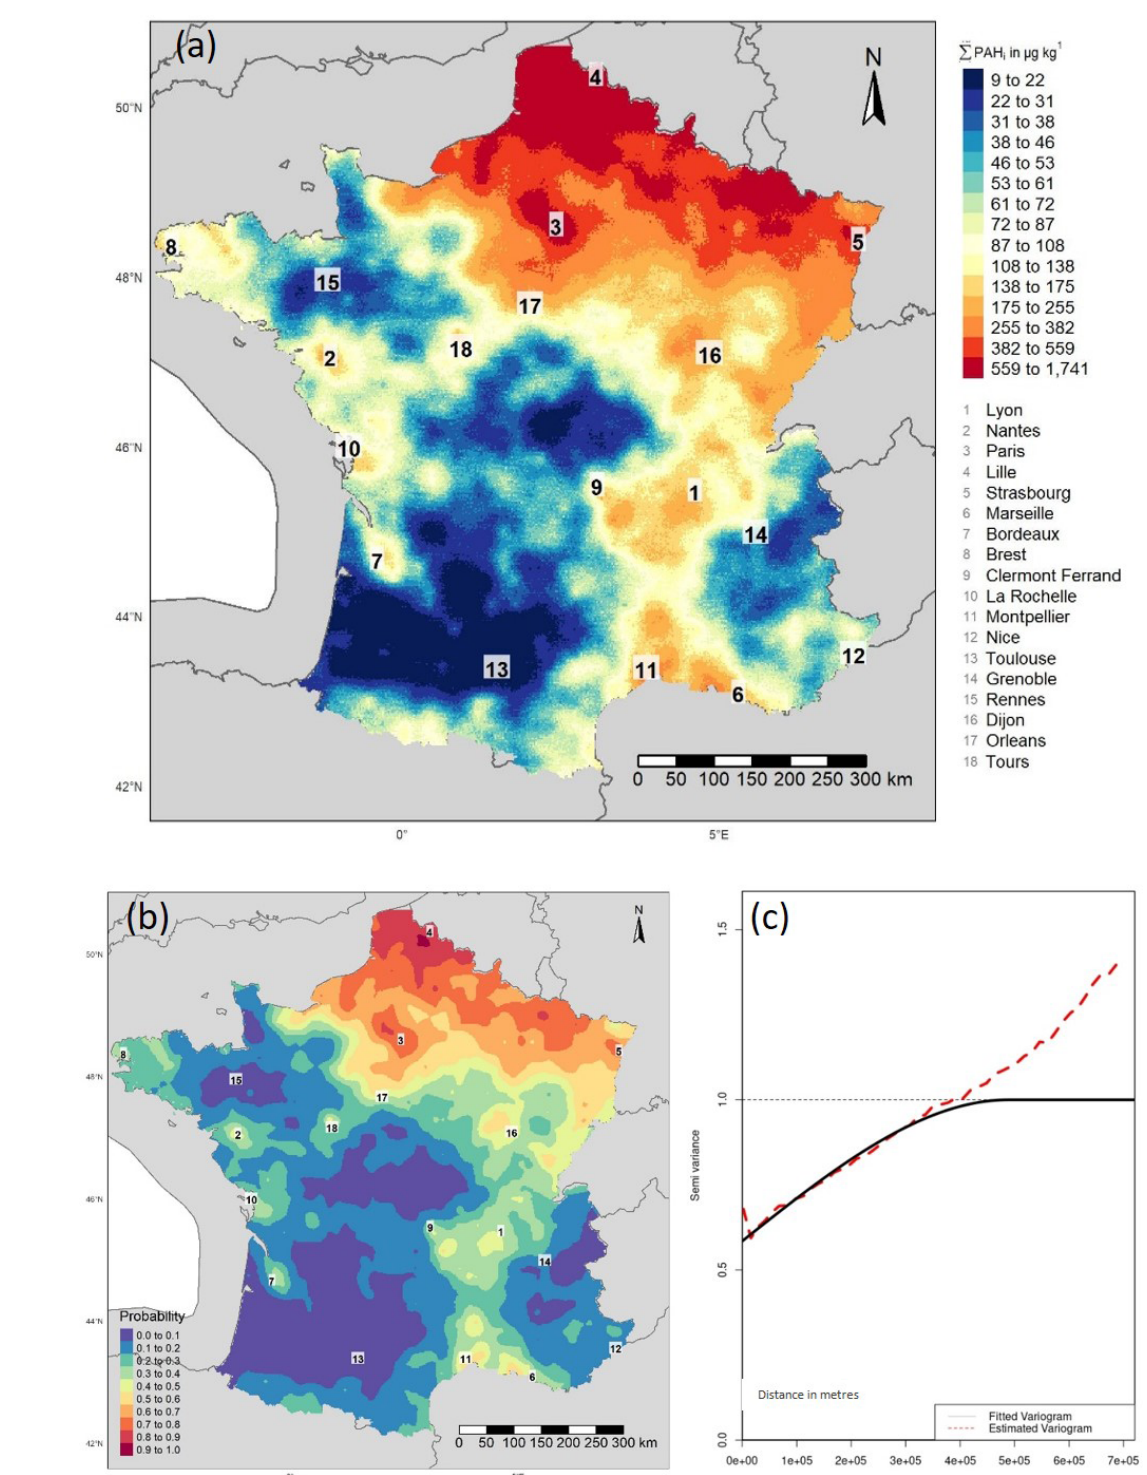
Figure 1. (a) The estimated spatial distribution of the total PAH ( (cid:54) 15 PAHs) concentrations in micrograms per kilogram by conditional expectation, along with major cities in France. (b) Map of the estimated probability of exceeding 100µgkg − 1 in the (cid:54) 15 PAHs. (c) Estimated (in red) and fitted (in black) variograms of the normally scored transformed (cid:54) 15 PAHs.